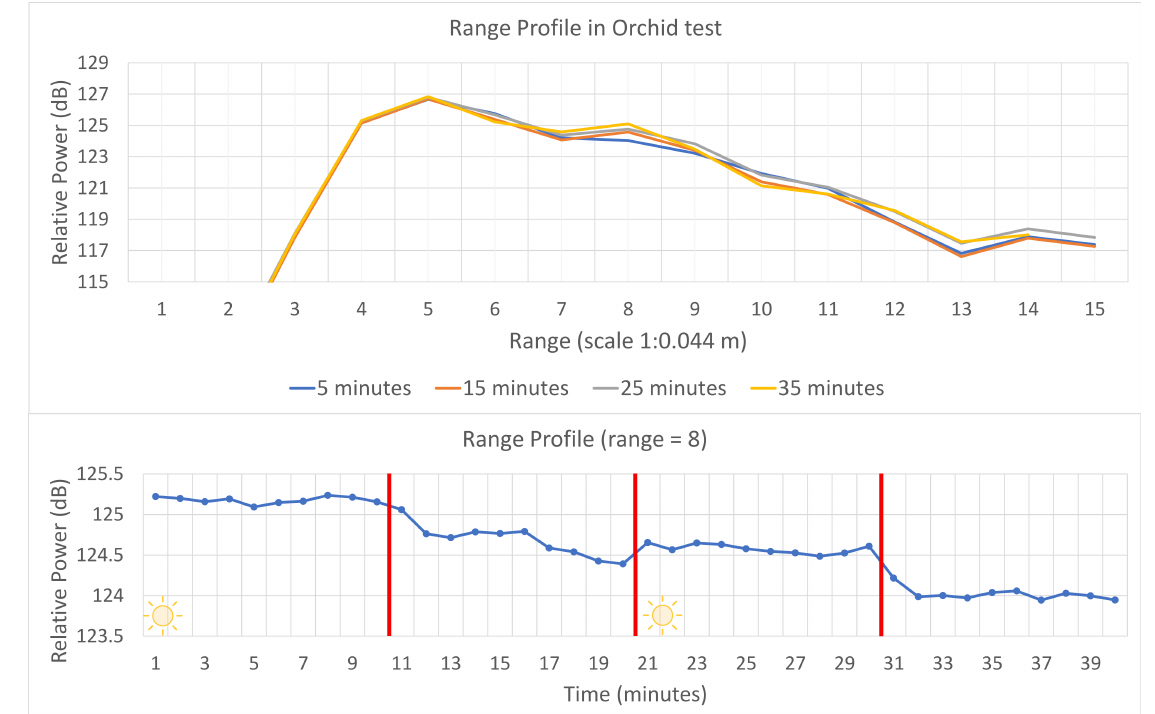
Figure 13. Test results with an orchid; red lines—block or unblock of solar